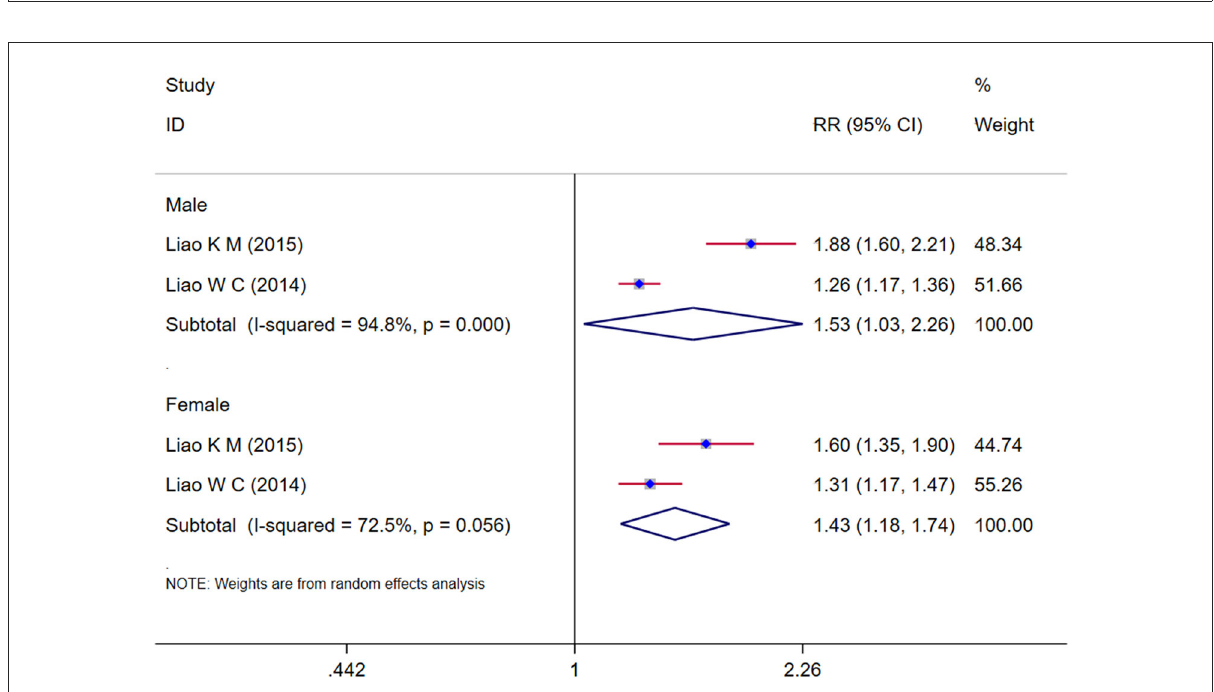
FIGURE3 Subgroup analysis by gender evaluating the risk of dementia in COPD patients.